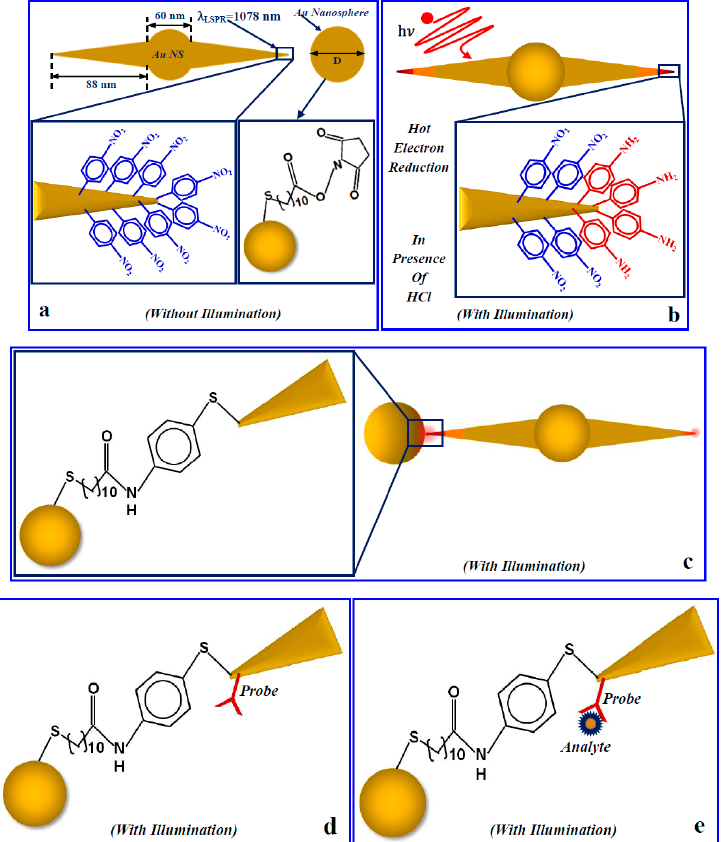
Figure 4. Design of a hybrid AuNS-nanosphere plasmonic antenna via the local surface chemistry modification method. ( a ) AuNS surface modified by 4-NTP and Au nanosphere coated